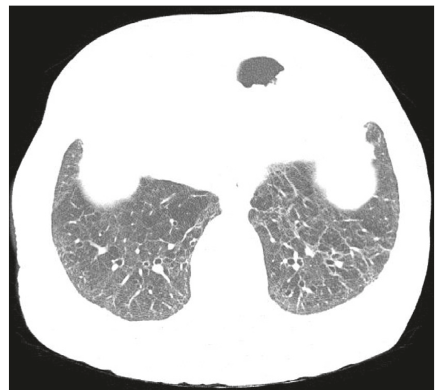
Figure 4: Chest CT in a lung window. An axial section at the level of the lower lobes highlights parenchymal bands and bronchiec- tasis. Fibrosis-like lesions pattern.